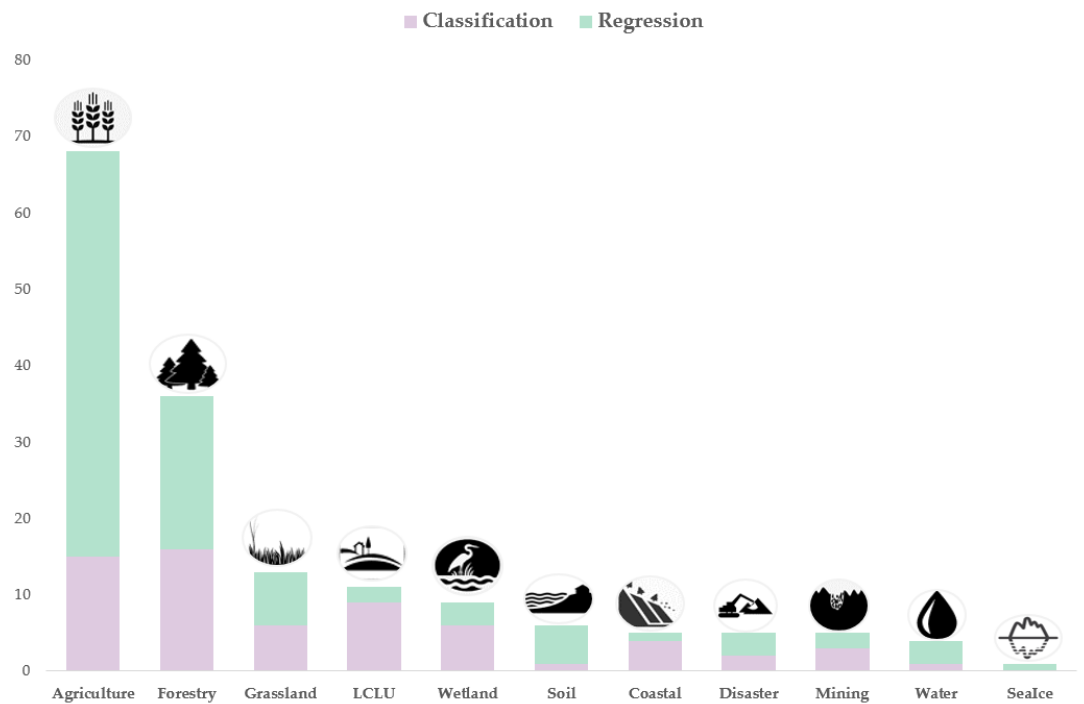
Figure 8. The number of studies per agro-environmental monitoring application. The purple bars represent the number of studies with classification purposes. The green bars represent the number of studies with regression purposes.